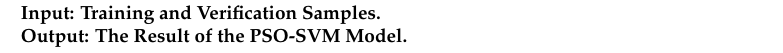
Table 1. Procedures of the PSO-SVM algorithm.